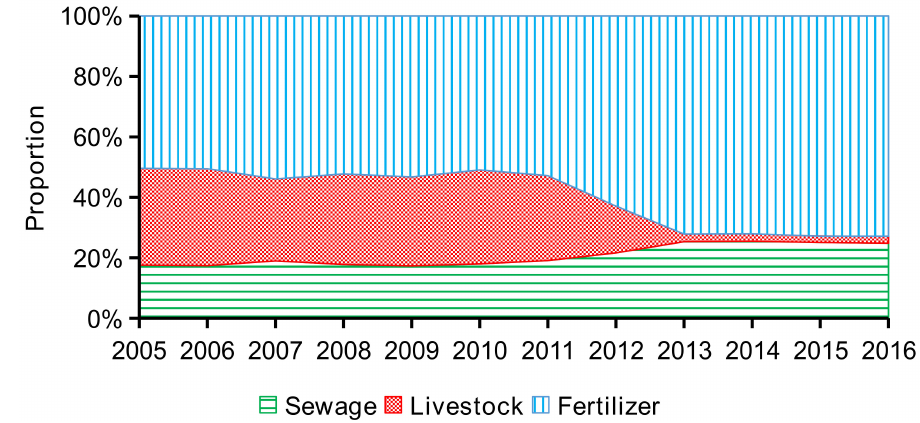
Figure 6. Source apportionment of anthropogenic P inputs within SDWSA (Shanxi Drinking-Water Source Area)